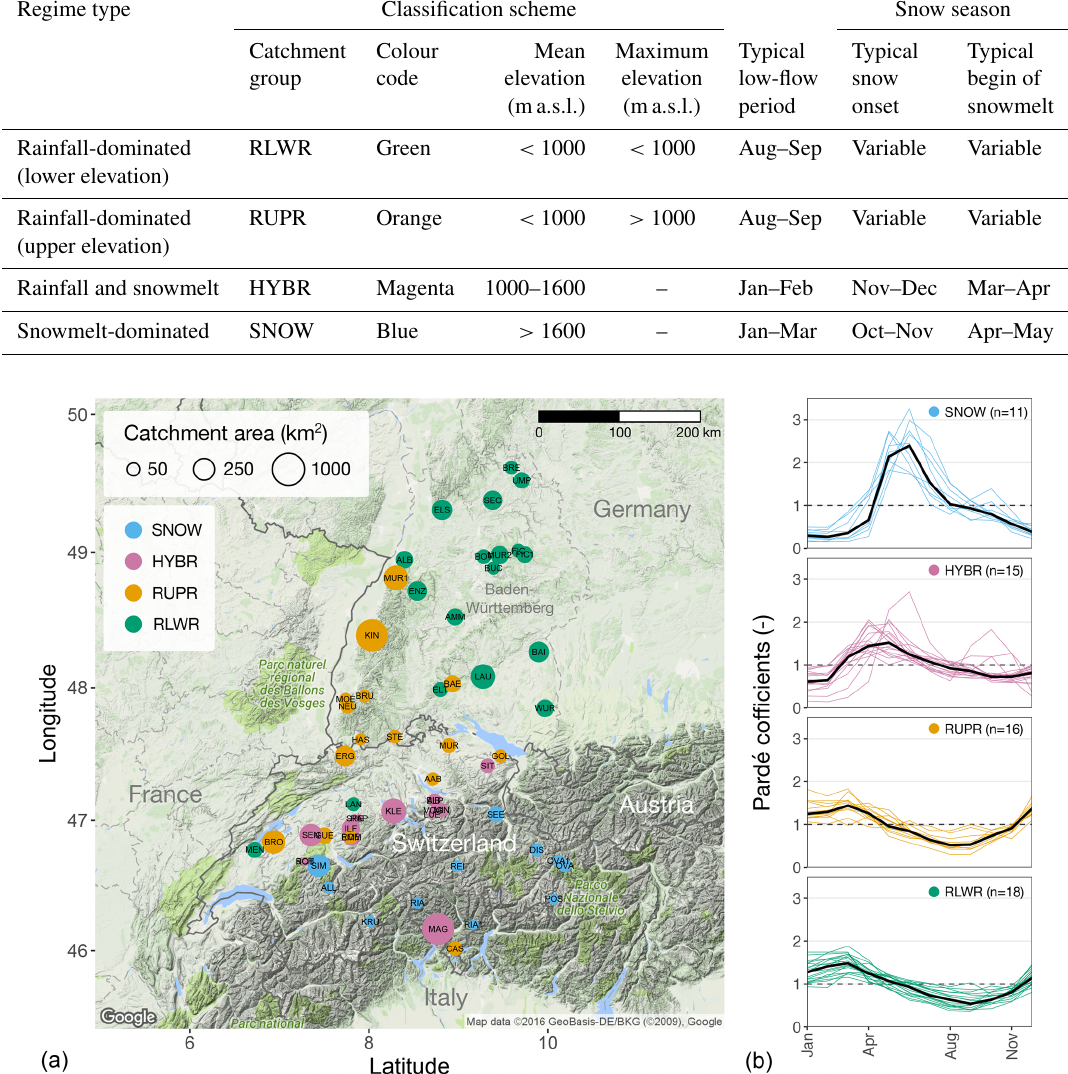
Figure 4. Location and area (size of circle) of study catchments. Catchment classification (colours) is explained in Table 1. Panel (b) shows the Pardé coefficients, i.e. the ratio of the long-term mean monthly streamflow to the long-term mean annual streamflow for all catchments grouped by regime